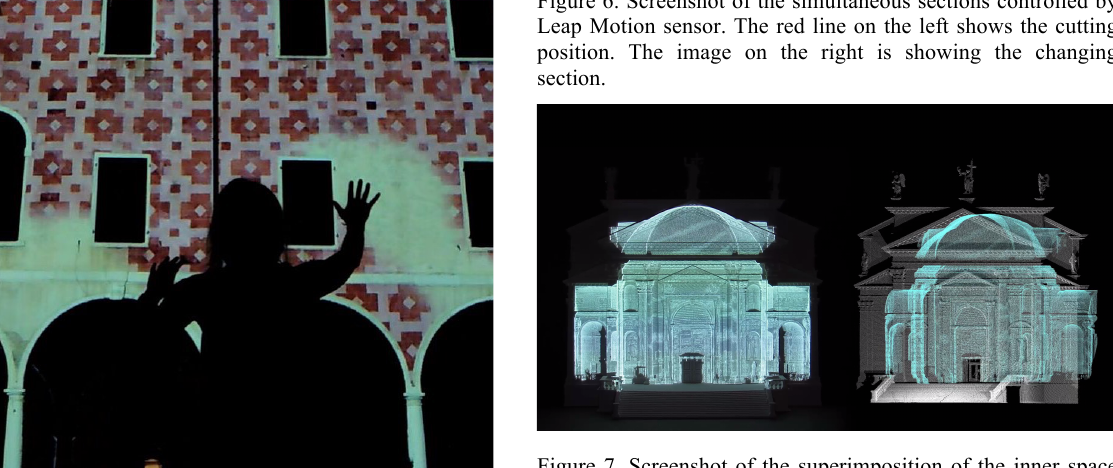
Figure 7. Screenshot of the superimposition of the inner space on the facade.